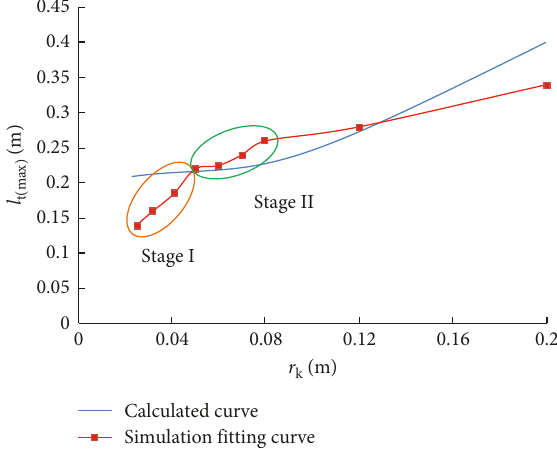
Figure 11: Variation in l